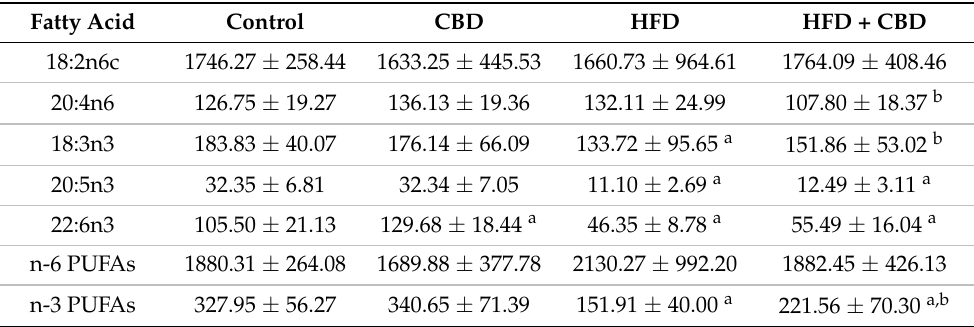
Table 10. Polyunsaturated fatty acids (PUFA) content in the plasma TAG fraction (nmol/mL of plasma) in the control (standard diet) and high-fat diet (HFD) groups after two-week cannabidiol (CBD)